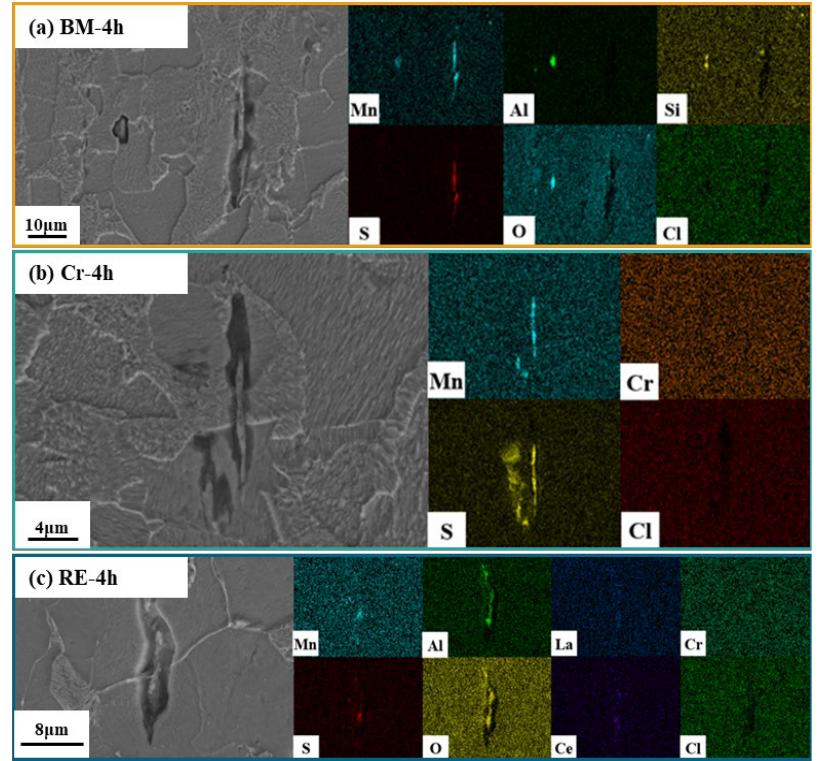
Figure 5. Immersion test results of ( a ) BM, ( b ) Cr, and ( c ) RE steel rebars after 4 h.